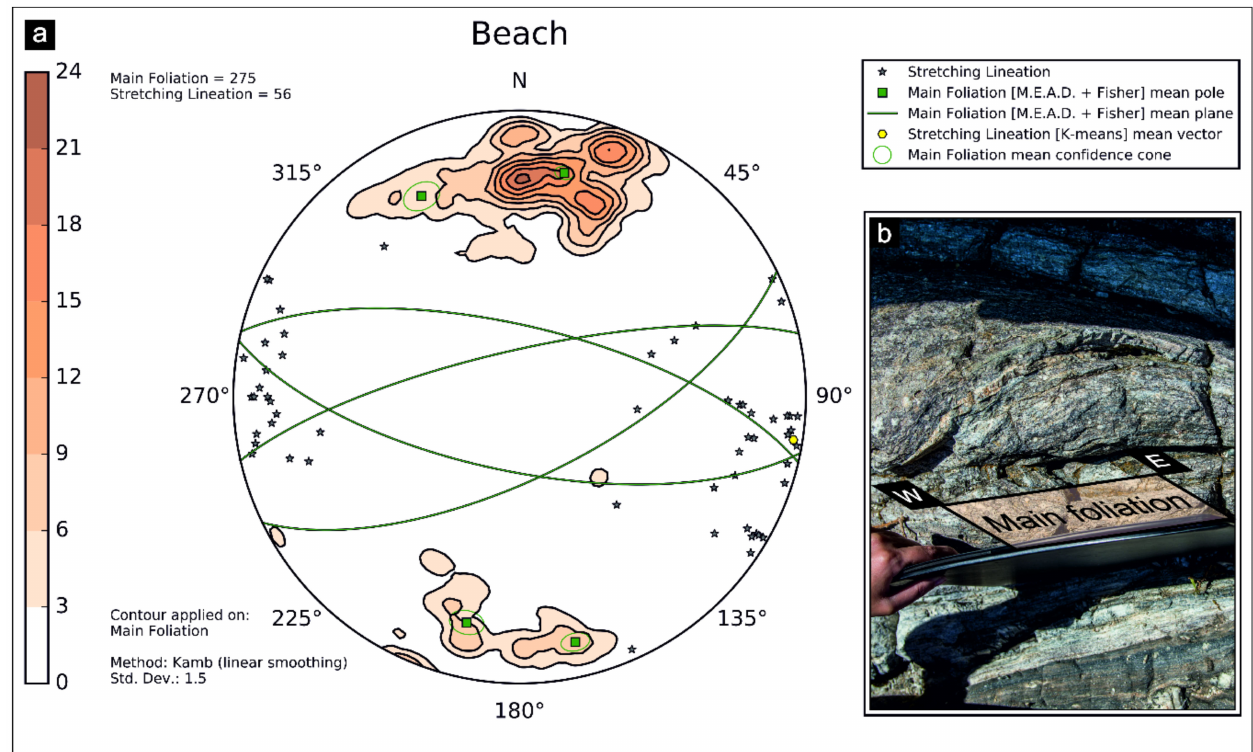
Figure 15. ‘Beach’ station: ( a ) equal-area azimuthal projection and statistical analysis of main foliations and stretching lineation data and ( b ) field example of W–E oriented mylonitic foliation developed in tonalites interlayered with paragneisses. The ASN log file is provided in Appendix B (Table